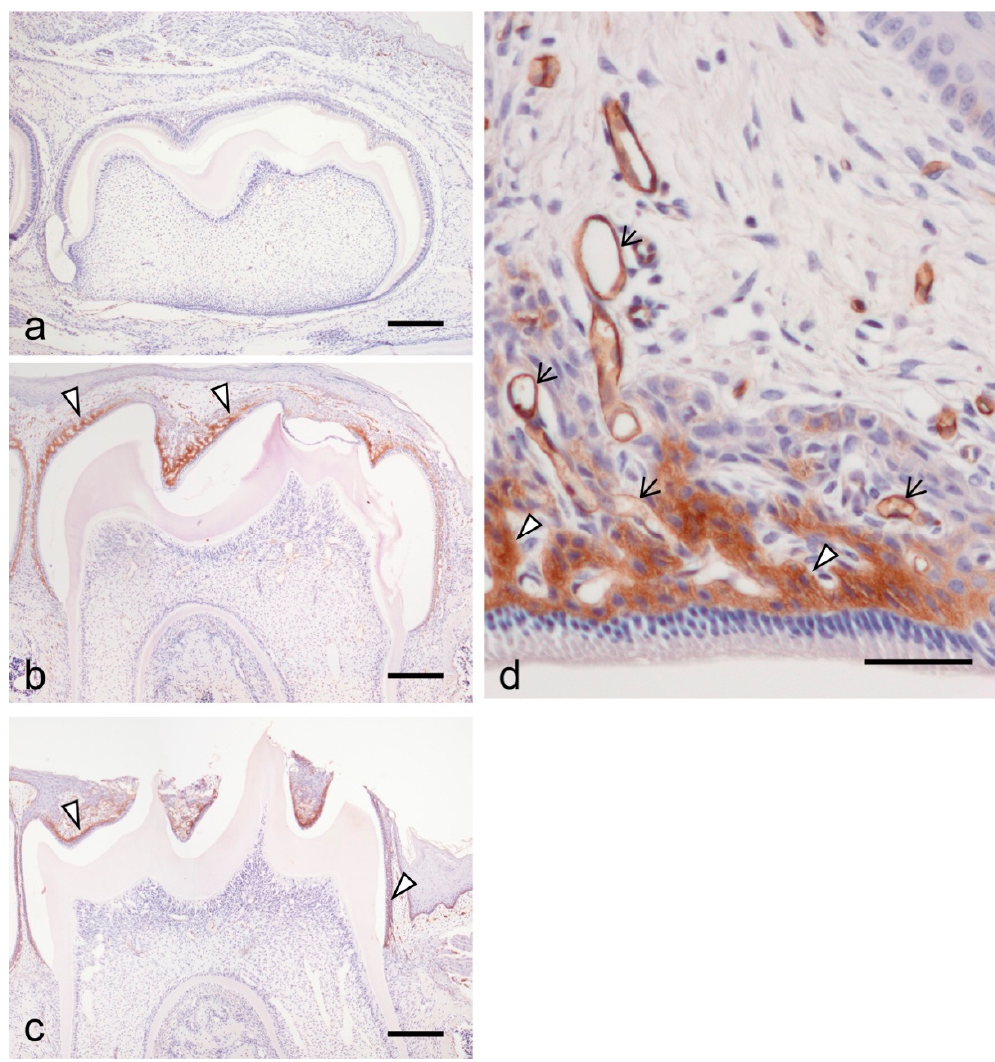
Figure 1. The expression of intercellular adhesion molecule-1 (ICAM-1) during the tooth organ development at 7 days postnatal (dPN) ( a ), 14 dpN ( b ), and 19 PN ( c , d ). ( a ) No clear expression of ICAM-1 was detected in the tooth organ. ( b ) ICAM-1 was detected at the papillary layer cells (arrowheads). ( c ) Strong reactions of ICAM-1 expression were also detected in the papillary layer (arrowheads). ( d ) Higher magnification of the enamel organ at 19 dPN. ICAM-1 expressed in blood vessels (arrows) in addition to the papillary layer (arrowheads). Bars = 200 μ m in ( a – c ); 50 μ m in ( d ).